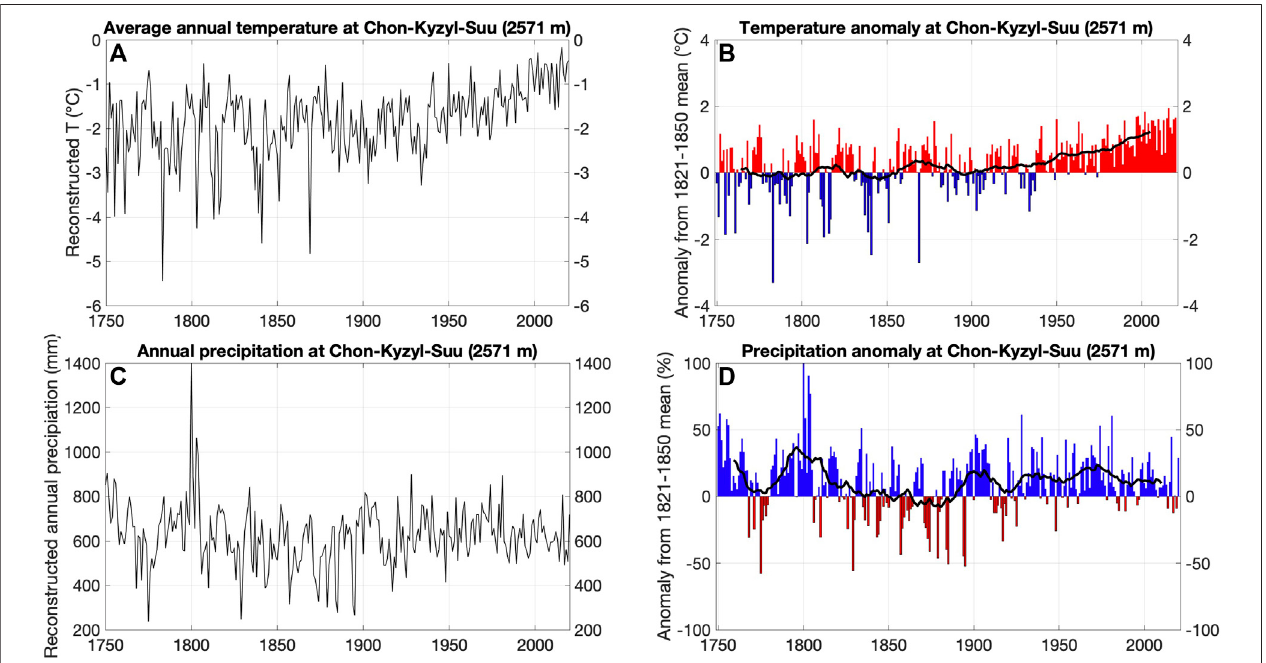
FIGURE 6 | Upper panels: Reconstructed and measured annual temperatures (A) and temperature anomalies (B) (from the 1821 – 1850) at the Chon-Kyzyl-Suu meteorological station. Lower panels: Reconstructed and measured annual precipitation (C) and precipitation anomalies (D) (from the 1821 – 1850) at the Chon-Kyzyl- Suu meteorological station.